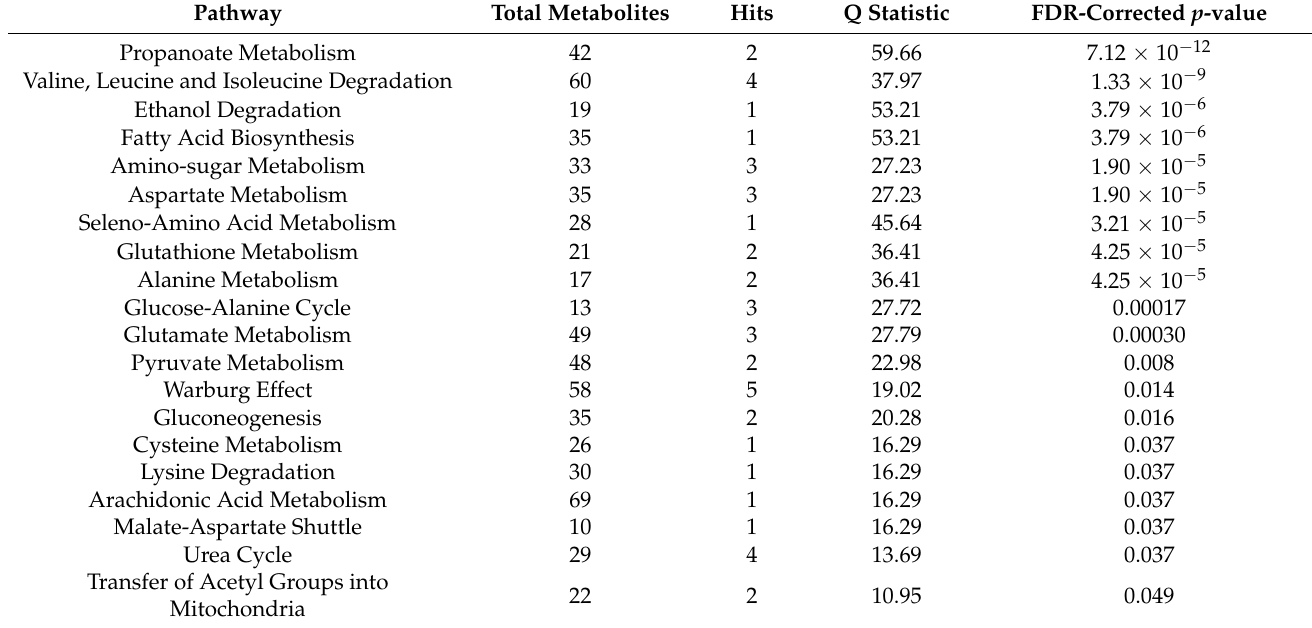
Table 6. Enrichment overview of QMSEA of the key biomarker dataset, showing pathway ‘hits’, computed Q statistic parameters, and their corresponding p values. All calculated p values indicated were corrected for multiple comparisons via the Holm–Bonferroni false discovery rate (FDR)